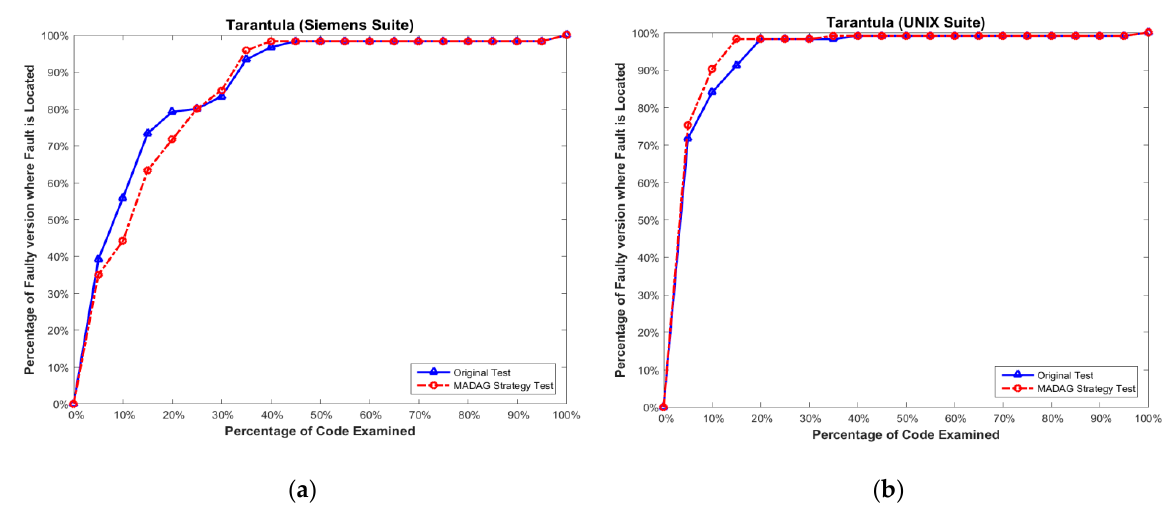
Figure 6. ( a ) Effectiveness comparison on the Siemens suite for Ochiai; and ( b ) on the UNIX suite for Ochiai.